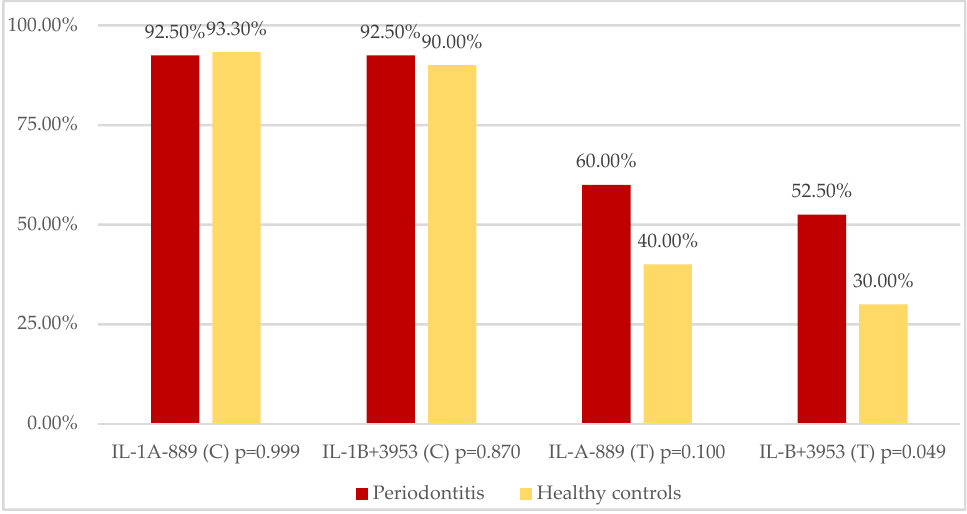
Figure 2. Frequencies of individuals carrying IL-1A − 889 and IL-1B +3953 C or T allele. An analysis of IL-1A − 889 and IL-1B +3953 genotype frequencies revealed that the IL- 1B +3953 C/T genotype was significantly more frequent in the group with periodontitis ( p = 0.016), whereas the prevalence of the IL-1B +3953 C/C genotype was significantly lower ( p = 0.029) (Figure 3). There was no difference in the distribution of the IL-1B +3953 T/T genotype. A similar trend was observed in the case of IL-1A − 889 genotypes; the differences between groups, however, were at the borderline of significance (Figure